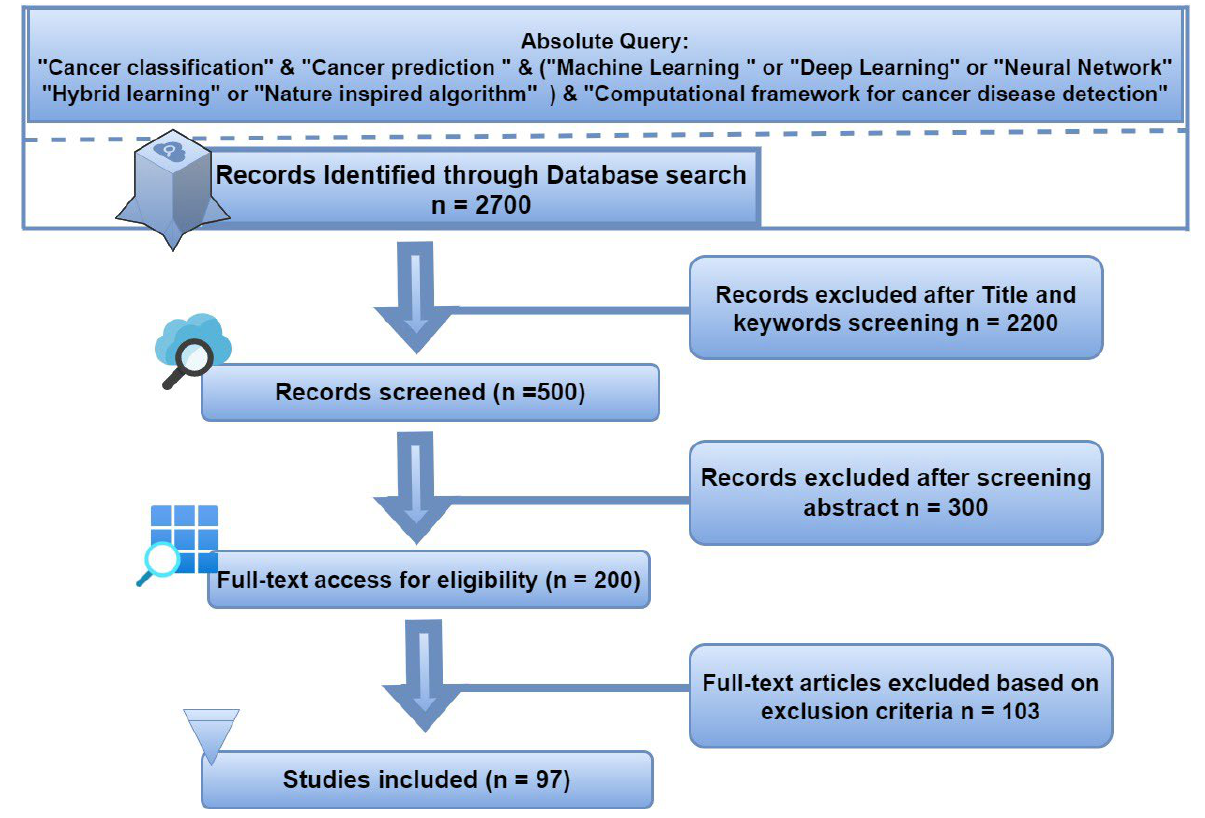
Figure 1. The PRISMA systematic flow of selection strategy for the